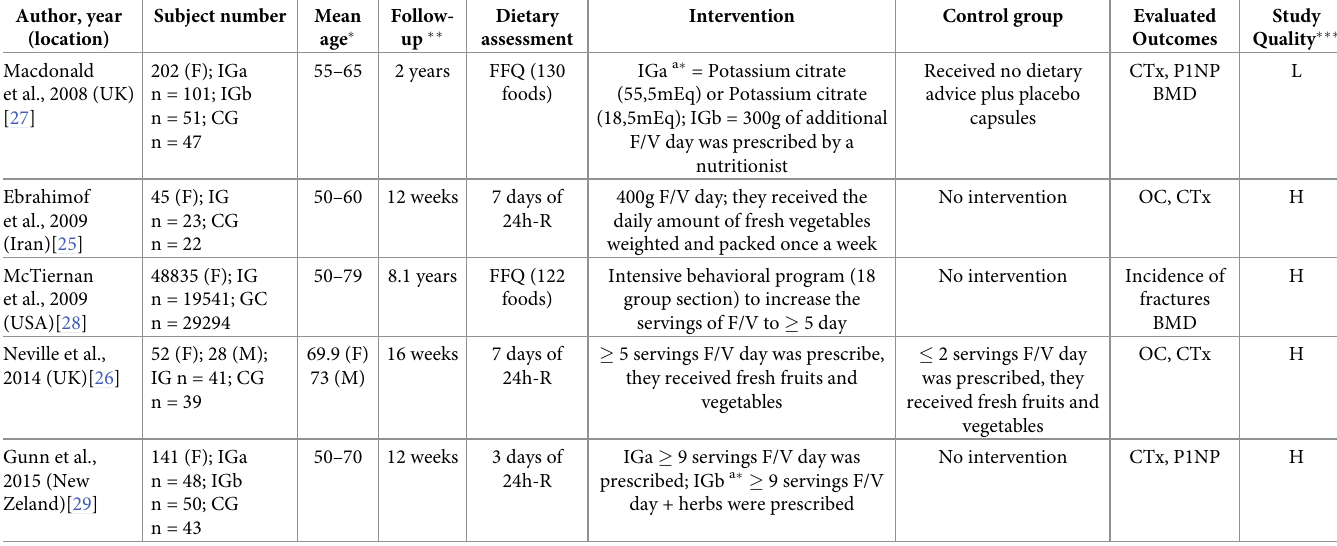
Table 2. Characteristics of randomized clinical trial included in the systematic review.